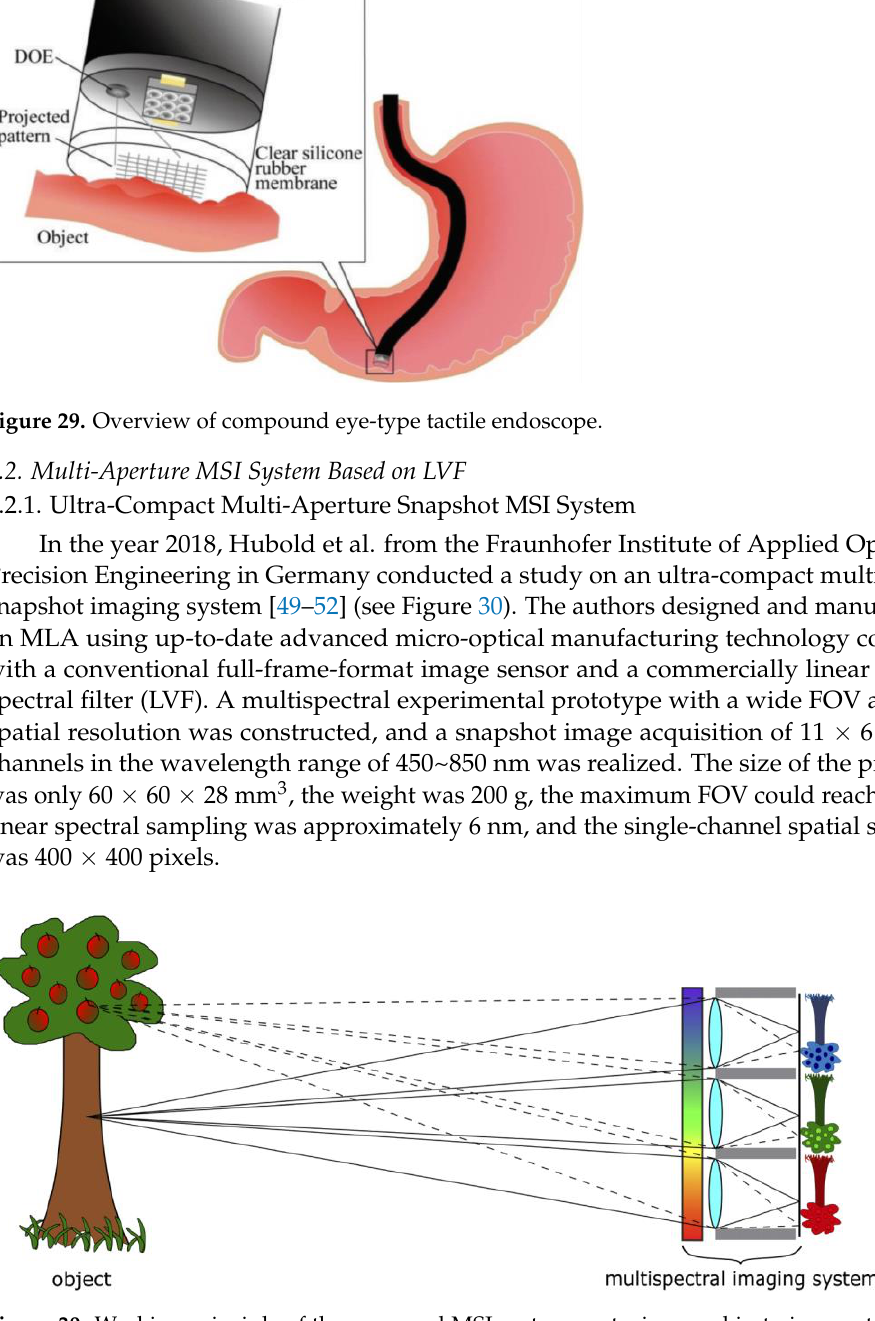
Figure 28. Multispectral images obtained from the experiments.